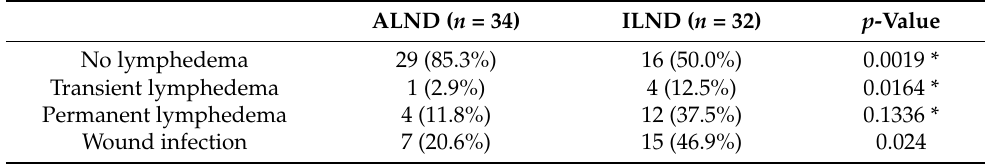
Table 2. Post-operative outcomes in axillary and inguinal lymph node dissections.